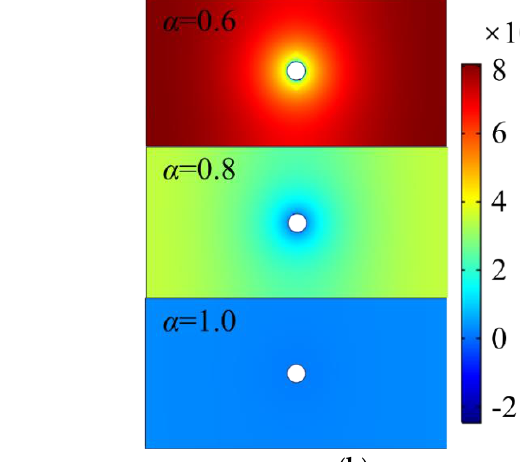
Figure 6. Matching result comparison of anomalous and normal diffusion with field test data. It can be seen from the anomalous diffusion formula that the change of fractional derivative order affects the gas pressure. Therefore, the influence of conformable deriva- tive order on gas pressure evolution with gas drainage time is discussed by curves and nephograms (Figure 7).